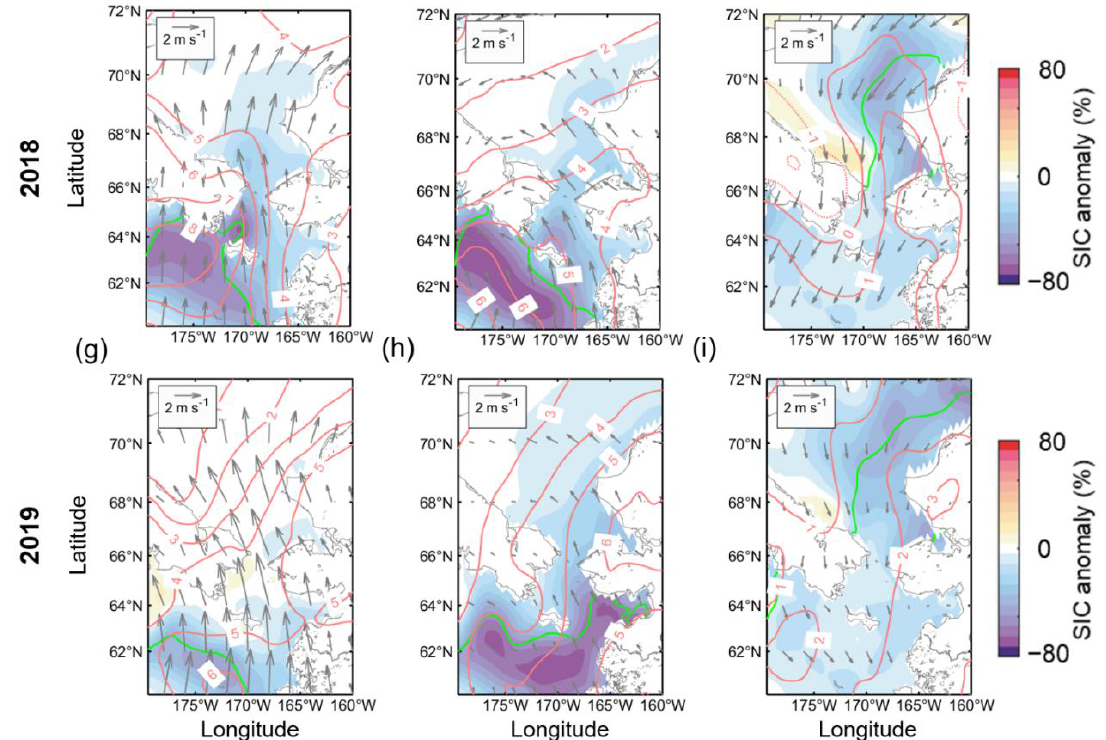
Figure 4. ( a – c ) Two-monthly composite climatology for SIC (color shading), T2M (red contours), and 10-m wind field (gray vectors) during January-June. Two-monthly composite anomalies for ( d – f ) 2018 and ( g – i ) 2019 for SIC, T2M, and wind field. The solid green line indicates marginal sea ice edge (SIC = 15%). Solid (dashed) lines indicate the positive (negative) contours of T2M.